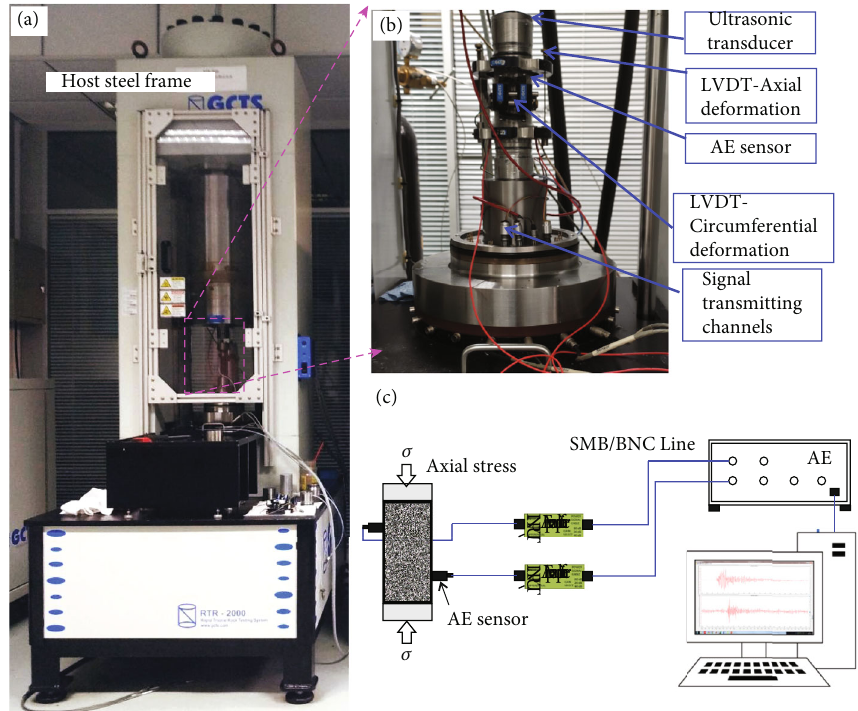
Figure 5: The testing system used for the increasing amplitude stress-cycling experiment ((a) GCTS 2000 rock mechanics machine, (b) LVDT system, and (c) scheme of AE system).